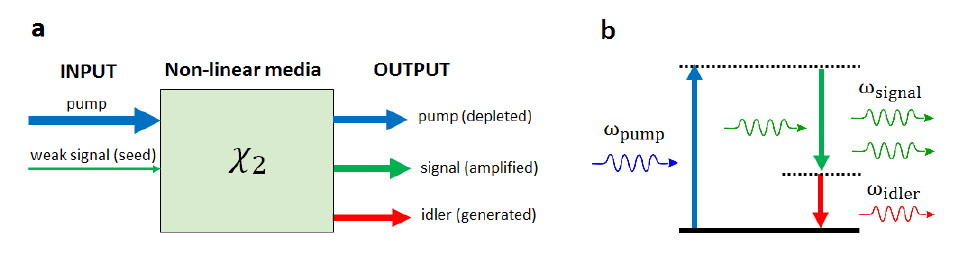
Figure 1. ( a ) Power flow from the pump beam to the signal beam in optical parametric amplification; ( b ) the same optical parametric amplification process can be viewed as stimulated emission of signal photons from a virtual level excited by the